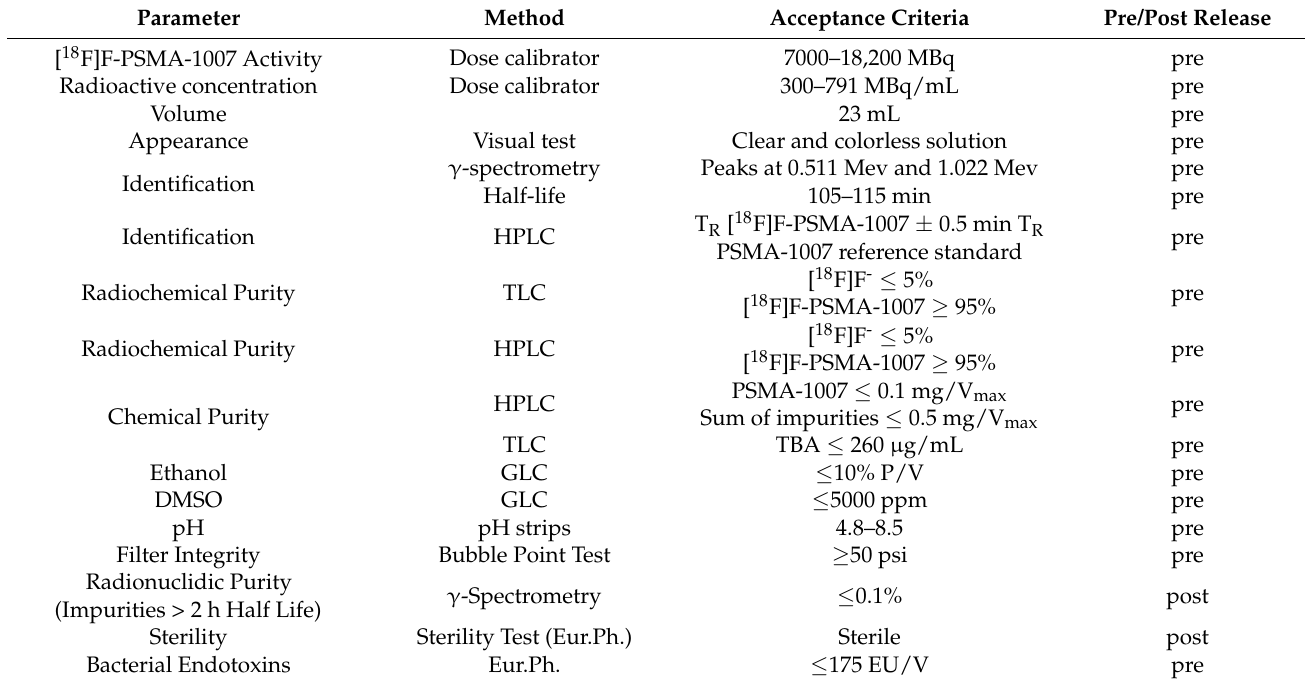
Table 4. Recommended test for the quality controls and pre/post-release time